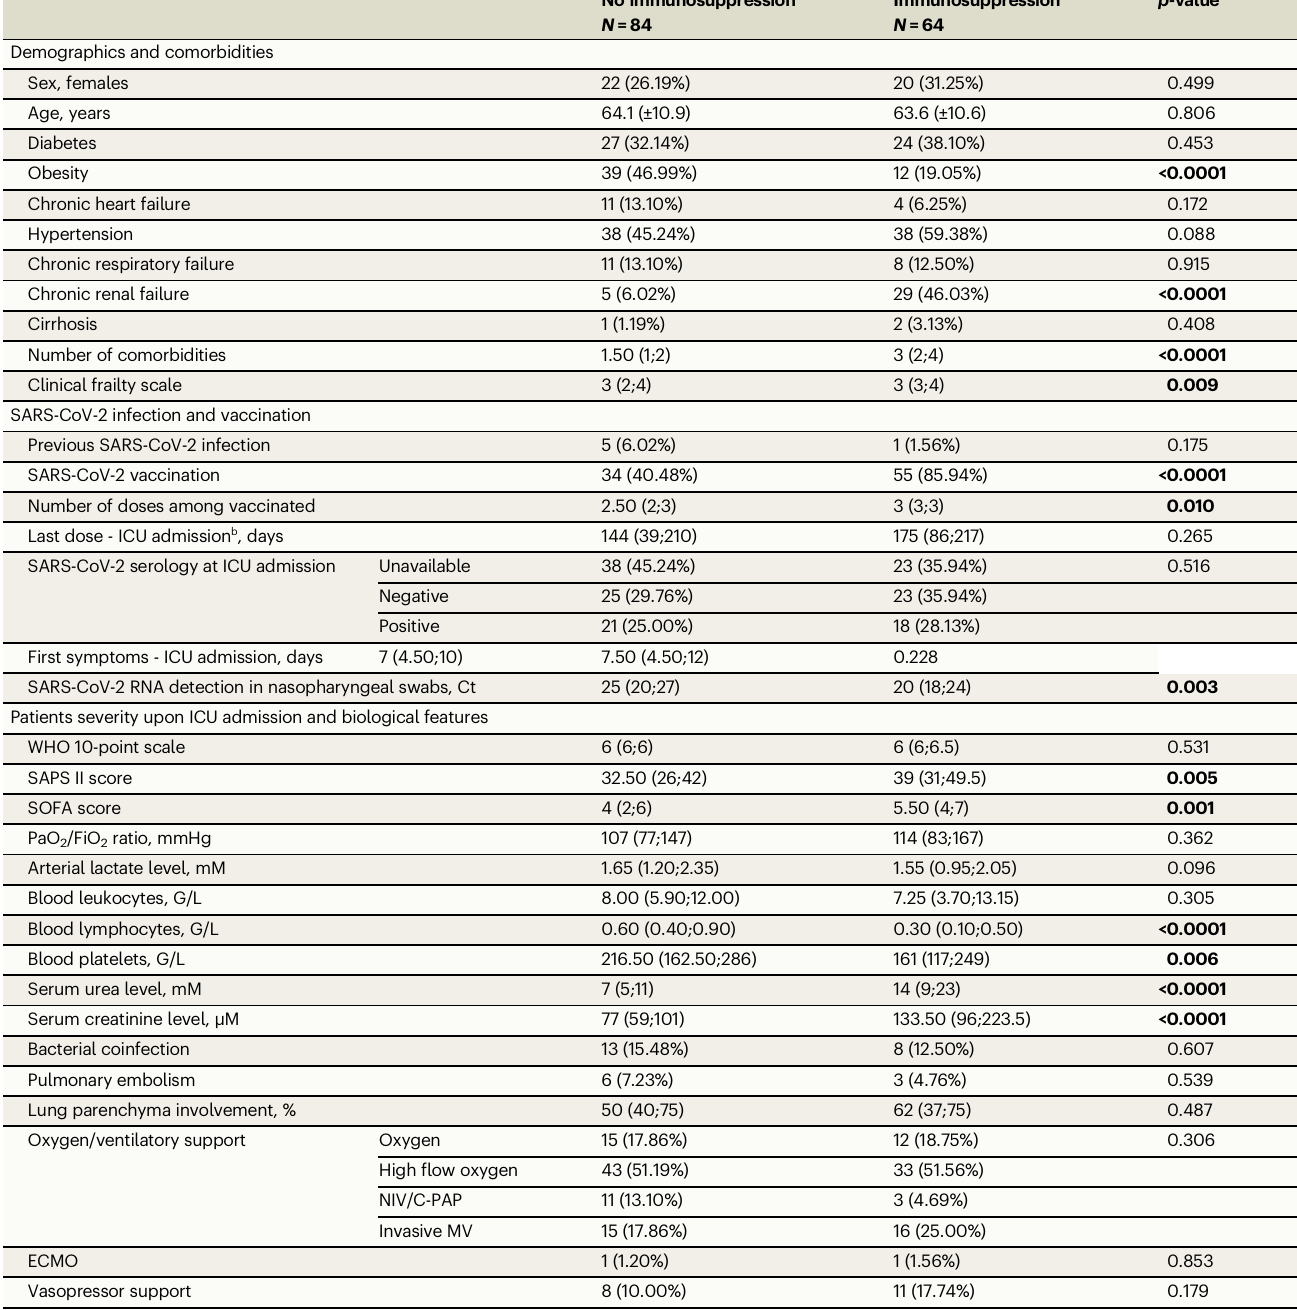
Table 4 | Clinical and biological characteristics of the 148 patients infected with variant Omicron at the time of ICU admission according to the existence of underlying